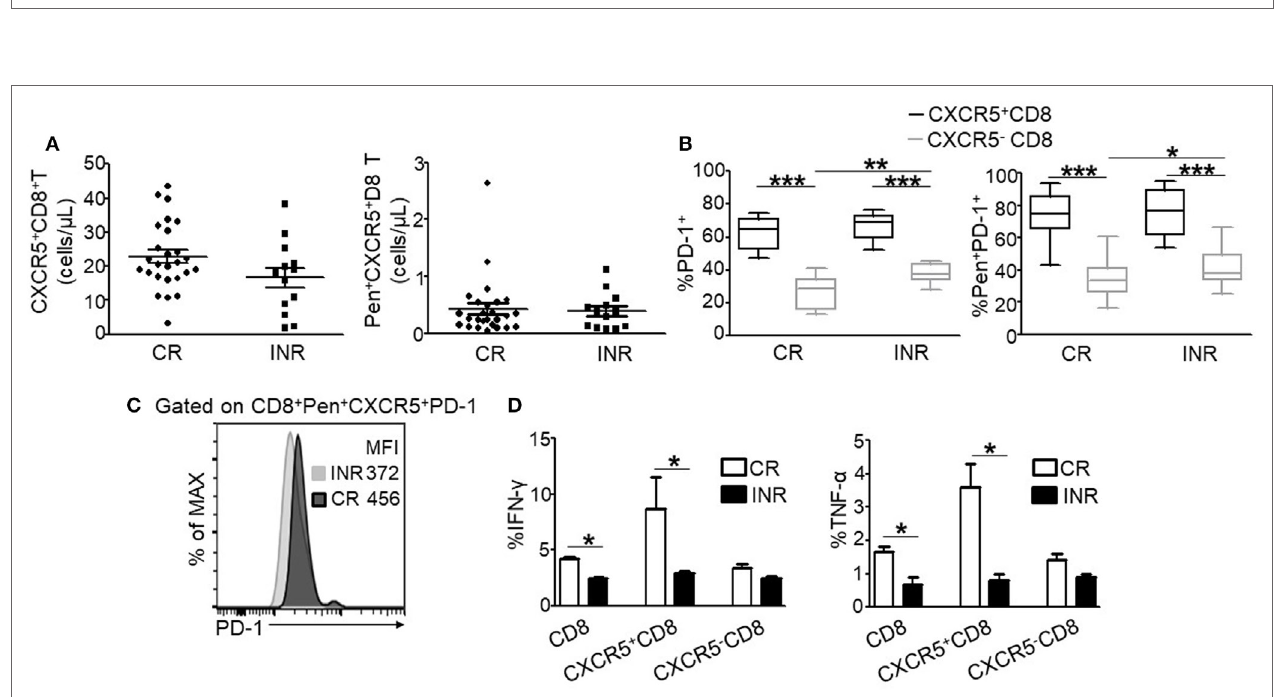
FigUre 6 | ART treatment fails to restore the function of HIV-specific CXCR5 + CD8 + T cells in immune non-responders (INRs) patients. (a) Comparing the number of CXCR5 + CD8 + T cells (left) and Pen + CXCR5 + CD8 + T cells (right) between the complete responders (CRs) and INRs. (B) Comparison of programmed cell death 1 (PD-1) expression on CXCR5 − and CXCR5 + CD8 + T cells gated on the total CD8 + (left) and Pentamer + CD8 + T cell (right) populations, respectively ( n = 26 for CRs; n = 13 for INRs). (c) Representative data of PD-1 mean fluorescence intensity (MFI) on Pentamer + CXCR5 + CD8 + T cells from CRs and INRs. The data represent three independent experiments with similar results ( n > 3 for each group). (D) IFN- γ (left) and TNF- α (right) production on the total, CXCR5 − , or CXCR5 + CD8 + T cells stimulated for 8 h using HIV-derived overlapping peptides ex vivo ( n > 8 for each group) . Each dot represents one individual patient. Statistical significance between two groups was determined by a Mann–Whitney non-parametric U test.